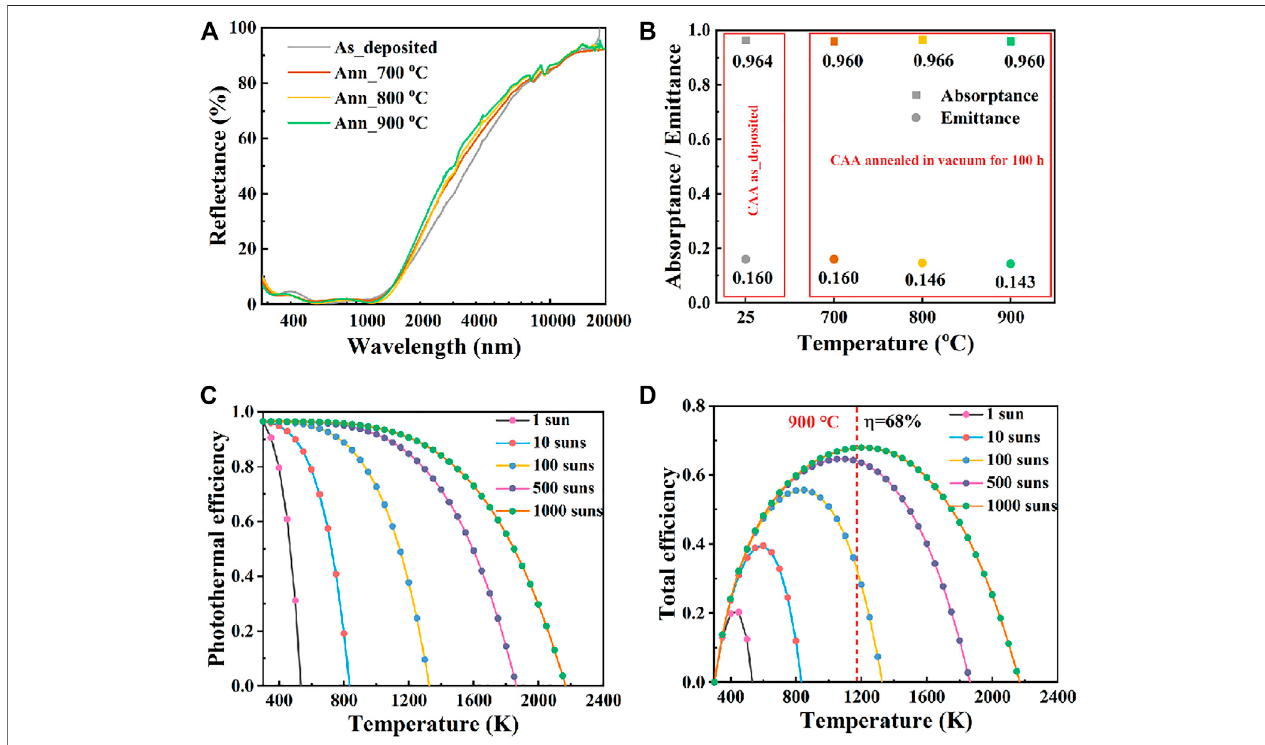
FIGURE3|(A) Re fl ectionspectraofthecoatings before(grayline)and afterannealinginvacuumat700 o C(orange line),800 o C(yellowline), and900 o C(green line) for 100 h. (B) The solar absorptance and thermal emittance of the absorber under different heat treatment conditions. (C) Temperature-dependent photothermal ef fi ciency with different optical concentrations. (D) Temperature-dependent total ef fi ciency with different optical concentrations. The vertical red dotted line represents the temperatures of 900 o